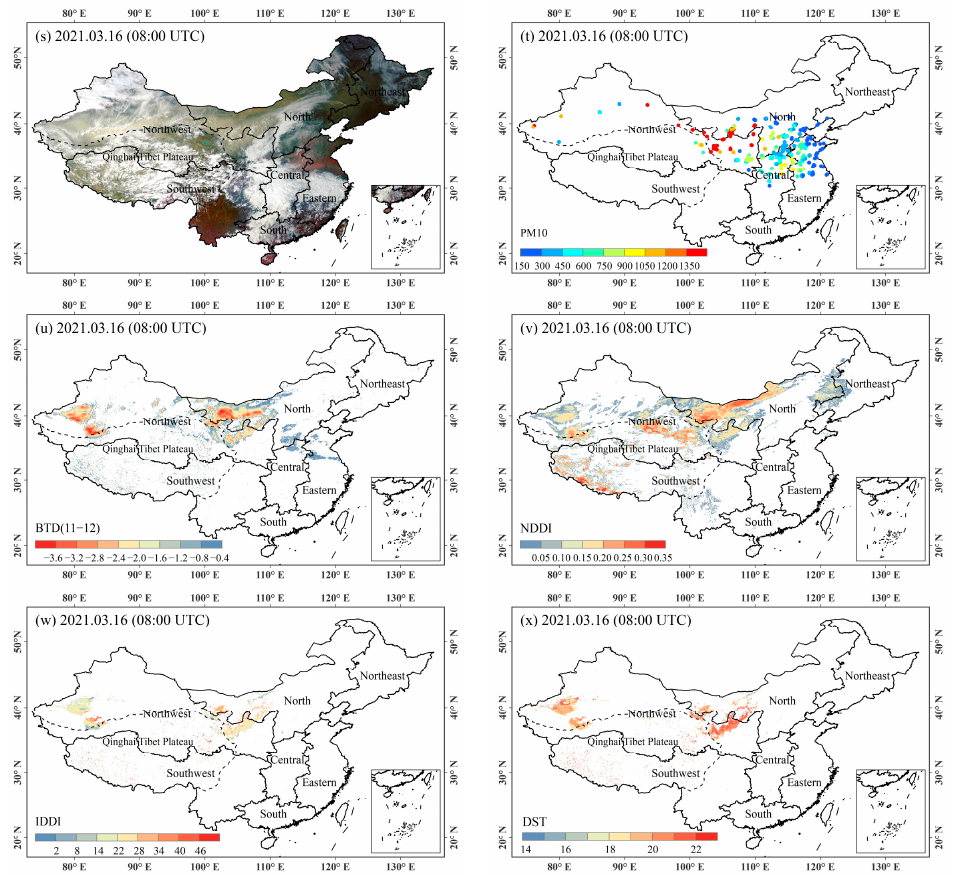
Figure 4. FY-4A AGRI true color images ( a , g , m , s ), PM10 ( b , h , n , t ), BTD ( c , i , o , u ), NDDI ( d , j , p , v ), IDDI ( e , k , q , w ), and DST ( f , l , r , x ) corresponding to the times of 16 March 2021 from 02:00 to 08:00 UTC, respectively.